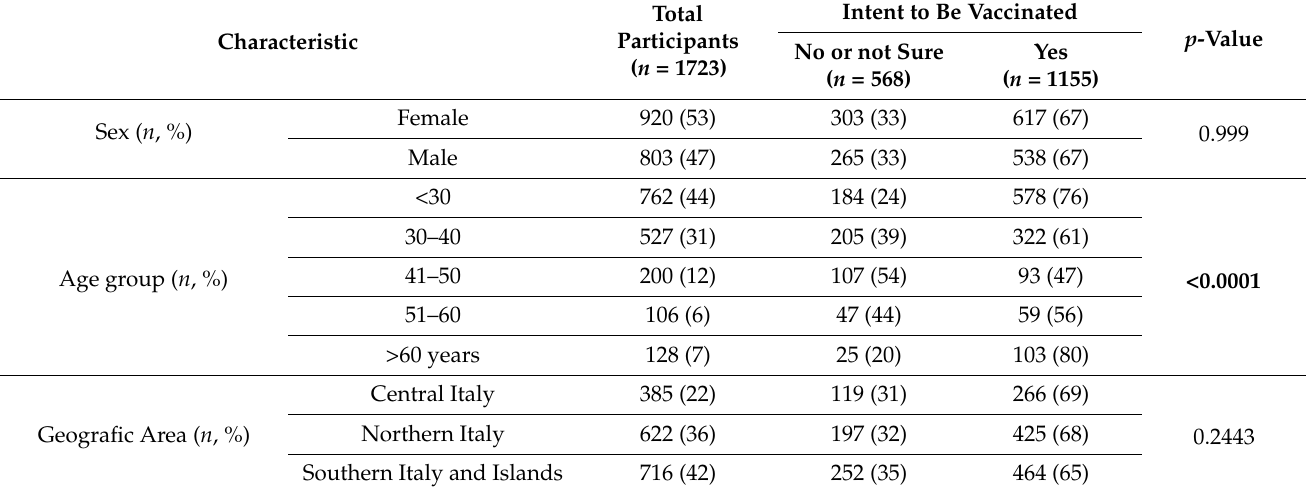
Table 1. Characteristics of the 1723 participants compared by being anti-SARS CoV2 vaccine hesitant or not.